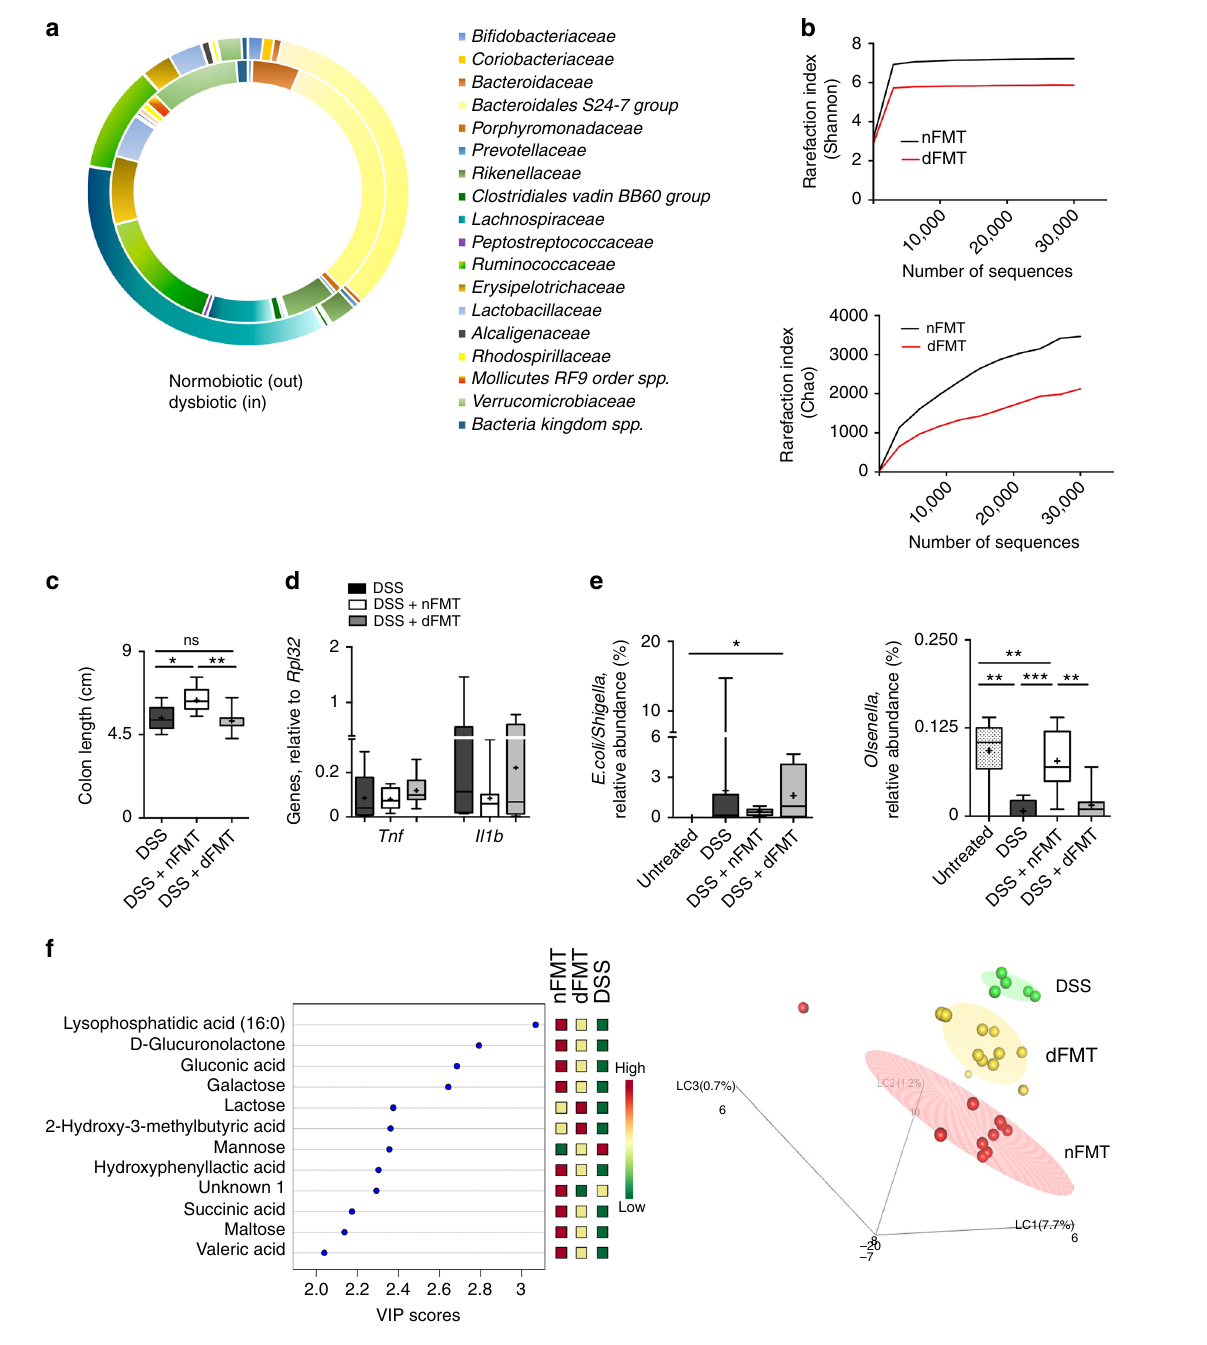
Fig. 3 FMT effects upon transfer of normobiotic or dysbiotic ecologies. a Comparison of relative abundancies of different taxa between normobiotic (outer chart) and dysbiotic (inner chart) faecal microbiota. b Rarefaction curves showing microbial richness based on the Chao1 index (right panel) and microbial richness and evenness on the Shannon index (left panel) Black curves, normal FMT samples, red curves, dysbiotic FMT samples. c Colon length of DSS (black boxes), DSS + nFMT (white boxes) or DSS + dFMT (gray boxes) treated mice. d Colonic expression of Tnf and Il1b in DSS (black boxes), DSS + nFMT (white boxes) or DSS + dFMT (gray boxes) treated mice. e Relative abundance of E.Coli/Shigella (left panel) and Olsenella (right panel) in untreated (dotted white boxes), DSS treated (black boxes), DSS + nFMT (white boxes) and DSS + dFMT (gray boxes) mice. f Partial Least square-discrimination analysis (PLSD-DA) on metabolomics data (right panel) and heat map of metabolites that have contributed most to class separation (left panel) of faecal samples of DSS, DSS + nFMT and DSS + dFMT treated mice. Statistical signi fi cance was calculated using a Mann – Whitney test for comparison within two groups or Kruskal – Wallis test with Dunn ’ s multiple comparison correction within more than two groups. * P < 0.05, ** P < 0.01, *** P < 0.001 were regarded as statistically signi fi cant. Outliers were detected with Grubb ’ s test. Non parametric distributions were represented as median + / − interquartile range. In Box and whiskers plots, centre line represents median; cross, represents mean. In ( a , b ) nFMT n = 7, dFMT n = 7. In ( c , d ) DSS n = 7, DSS + nFMT n = 13, DSS + dFMT n = 7. In ( e ) UT n = 6, DSS n = 8, DSS + nFMT n = 7, DSS + dFMT n = 7. In ( f ) DSS n = 5, DSS + nFMT n = 10, DSS + dFMT n =